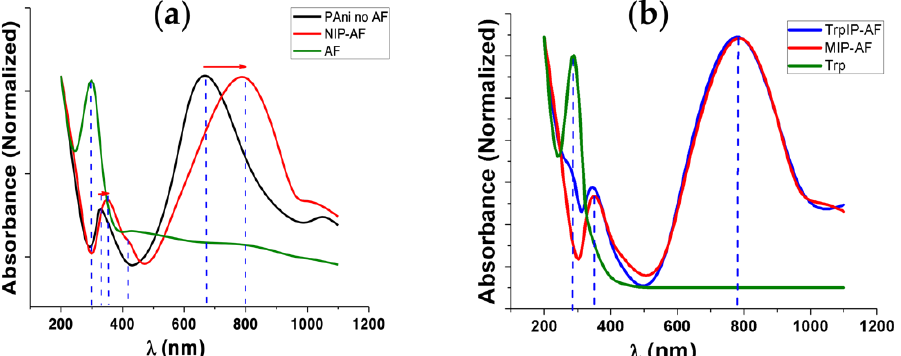
Figure 2. UV–VIS spectroscopy of aniline polymerization around AF; ( a ) UV–VIS spectra of bare amyloid fibril (AF, green line), aniline polymerized in the absence (Pani no AF, black line) and presence (NIP-AF, red line) of Afs; ( b ) UV–VIS of aniline polymerized around AF in the presence of template Trp on the surface (blue line), after extraction of Trp leading to MIP-AF (red line). Figure 2b reveals the distinctive peak for the aromatic ring of Trp at 280 nm (green